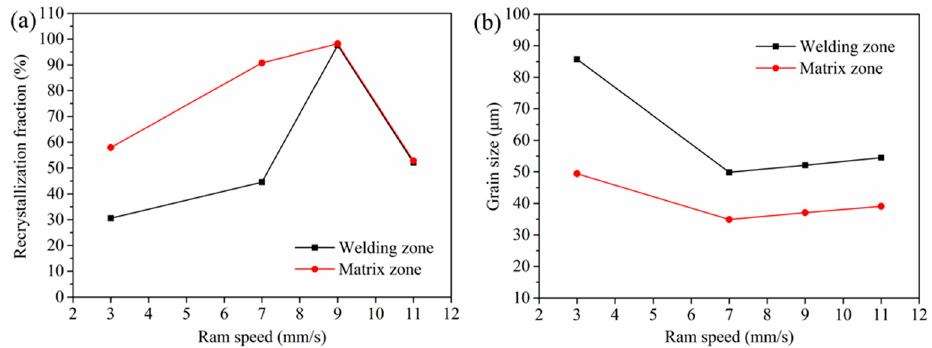
Figure 10. ( a ) DRX fractions and ( b ) grain sizes of porthole die extrusions at different ram speeds. Compared with the matrix zone, the DRX behavior in the welding zone was re- stricted. At the ram speed of 3mm/s, a relatively low DRX fraction was observed. An ap- proximately complete DRX occurred in the profile extruded at the ram speed of 9 mm/s. At the ram speeds of 3 mm/s, 7 mm/s, 9 mm/s, and 11 mm/s, the DRX fractions in the welding zone were 30.5%, 44.5%, 97.5%, and 52.1%, respectively. While the DRX fraction